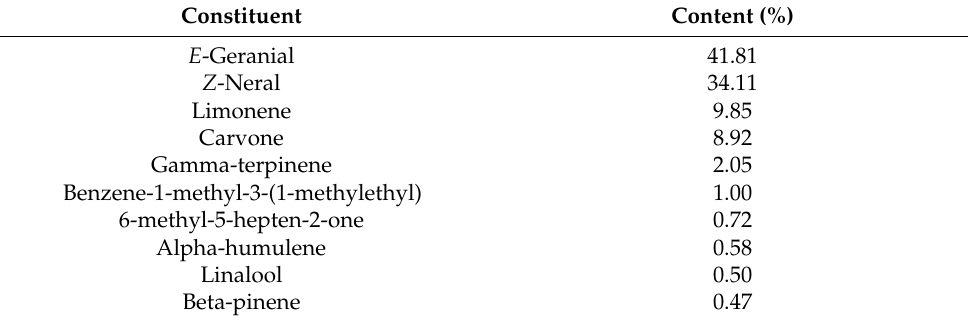
Table 2. Lippia alba essential oil